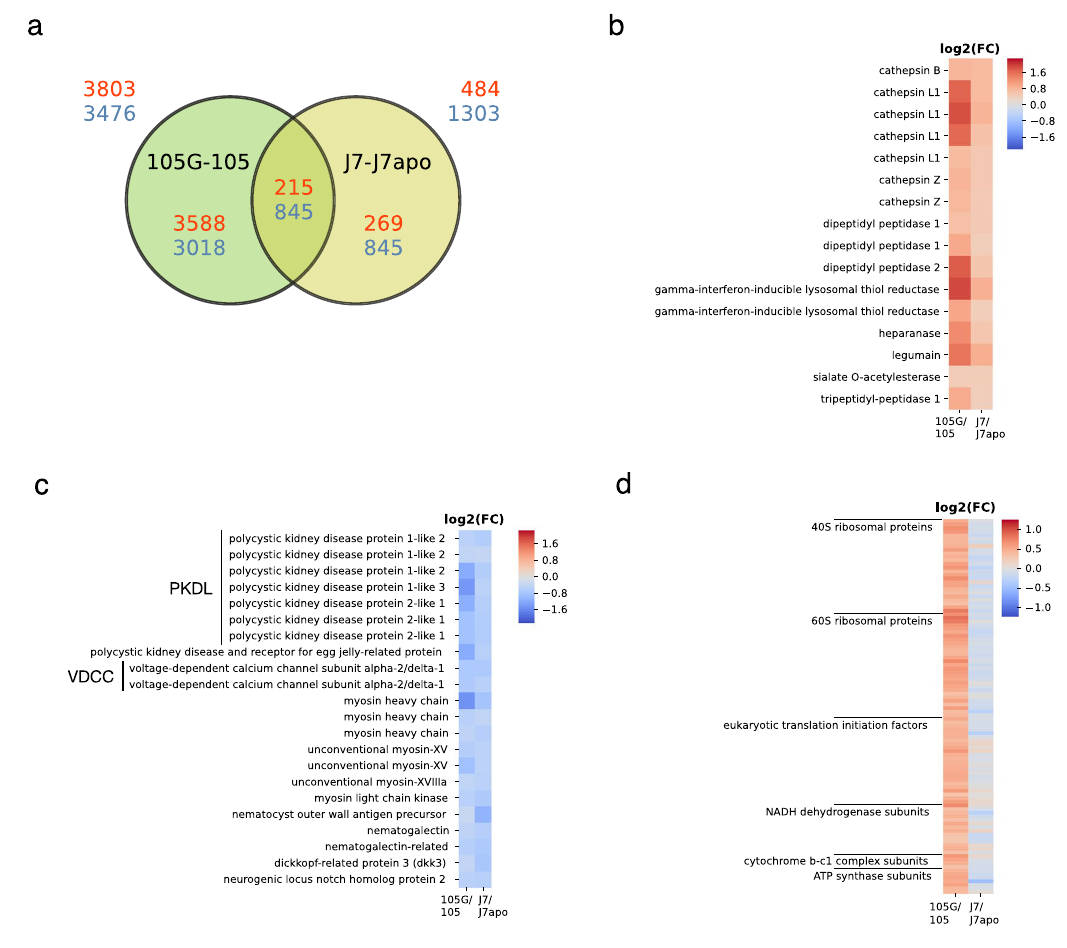
Figure 2. Comparison of the gene expression patterns in the 105G/105 and J7/J7apo pairs. ( a ) Venn diagram showing the number of differentially expressed genes (DEGs) in both strain pairs with the frag-bias-correct option (FDR < 0.05). The numbers of upregulated genes are indicated in red, and the numbers of downregulated genes are indicated in blue. ( b ) Heat map showing log2 fold change of the FPKMs (fragments per kilobase of exon per million mapped reads) of the upregulated genes coding lysosomal enzymes in both strain pairs. ( c ) Heat map showing log2 fold change of the FPKMs of the downregulated genes expressed in nematocytes or playing a role in nematocyte differentiation in both strain pairs. ( d ) Heat map showing log2 fold change of the FPKMs of the upregulated genes in the 105G/105 strain pair, encoding the genes related to translation and respiratory chain